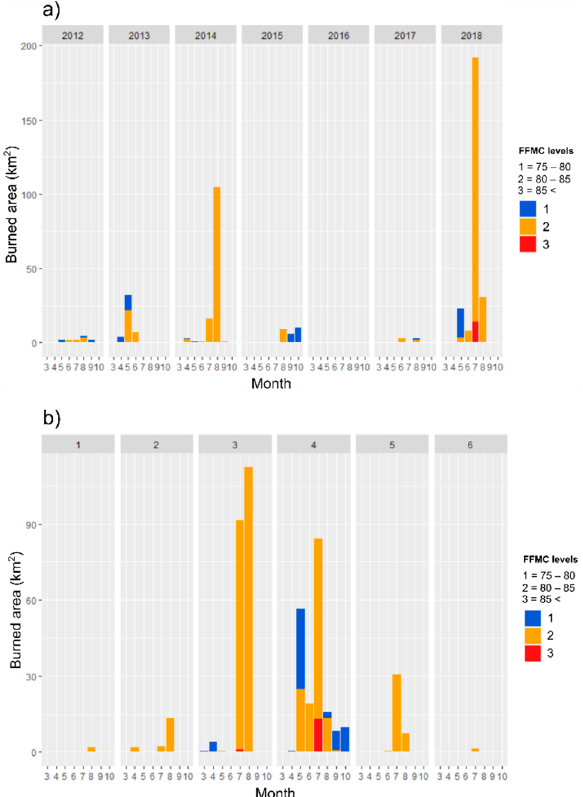
Figure 3. Burned area in Sweden divided by year ( a ) and vegetation zone ( b ).